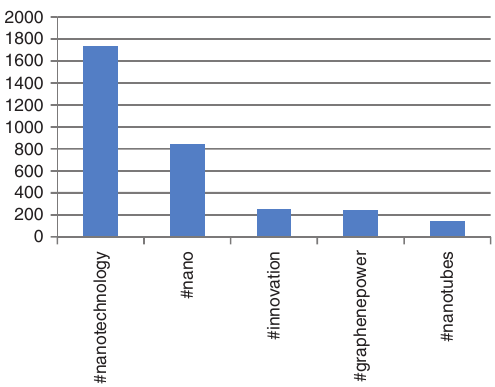
Figure 4: Top five (#) hashtags.